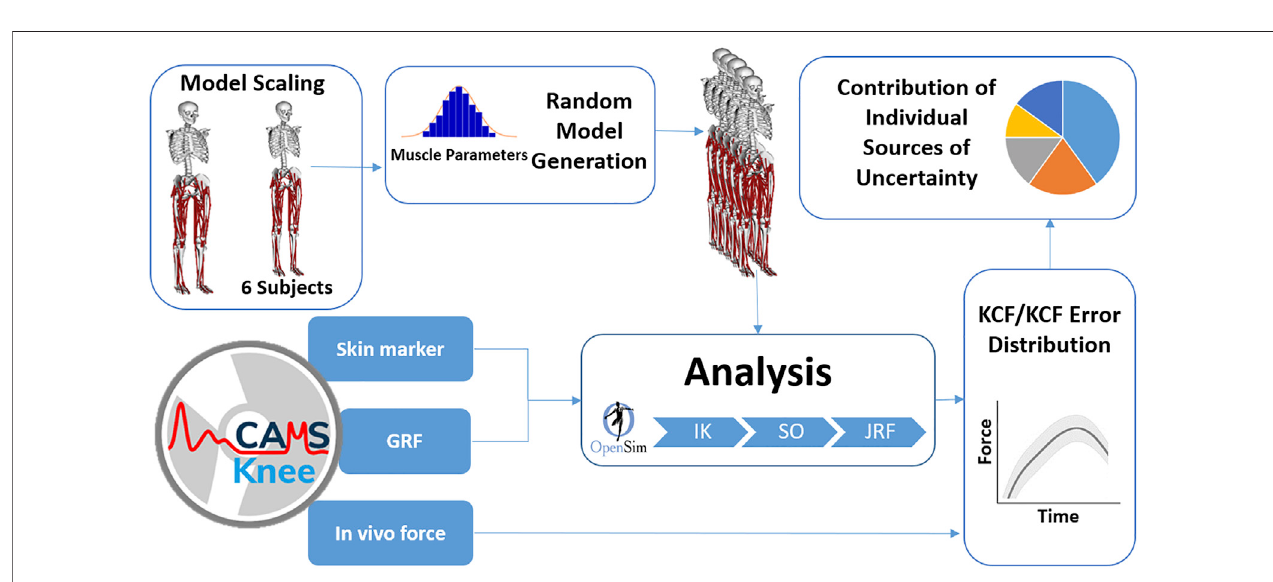
FIGURE 1 | Probabilistic modeling fl owchart. GRF, ground reaction force; IK, inverse kinematics; SO, static optimization; JRF, joint reaction force; KCF, knee contact force.